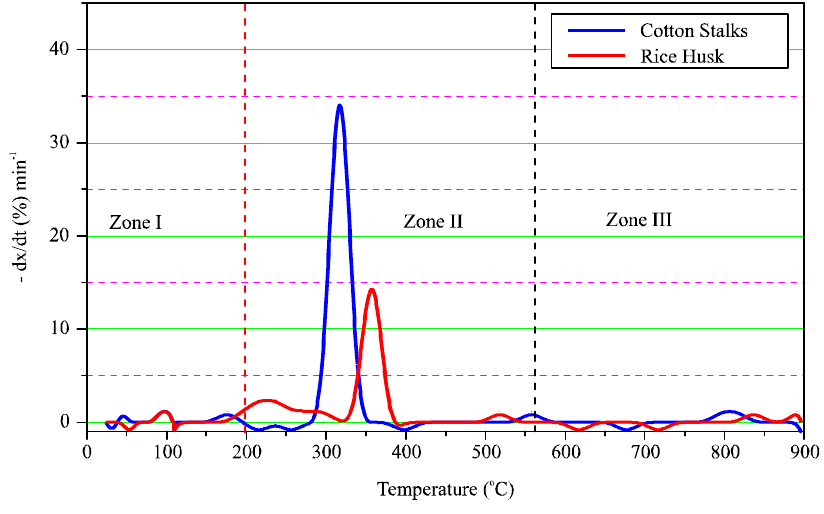
FIG. 5. DTG CURVE OF COTTON STALKS AND RICE HUSK SAMPLES UNDER OXIDATIVE